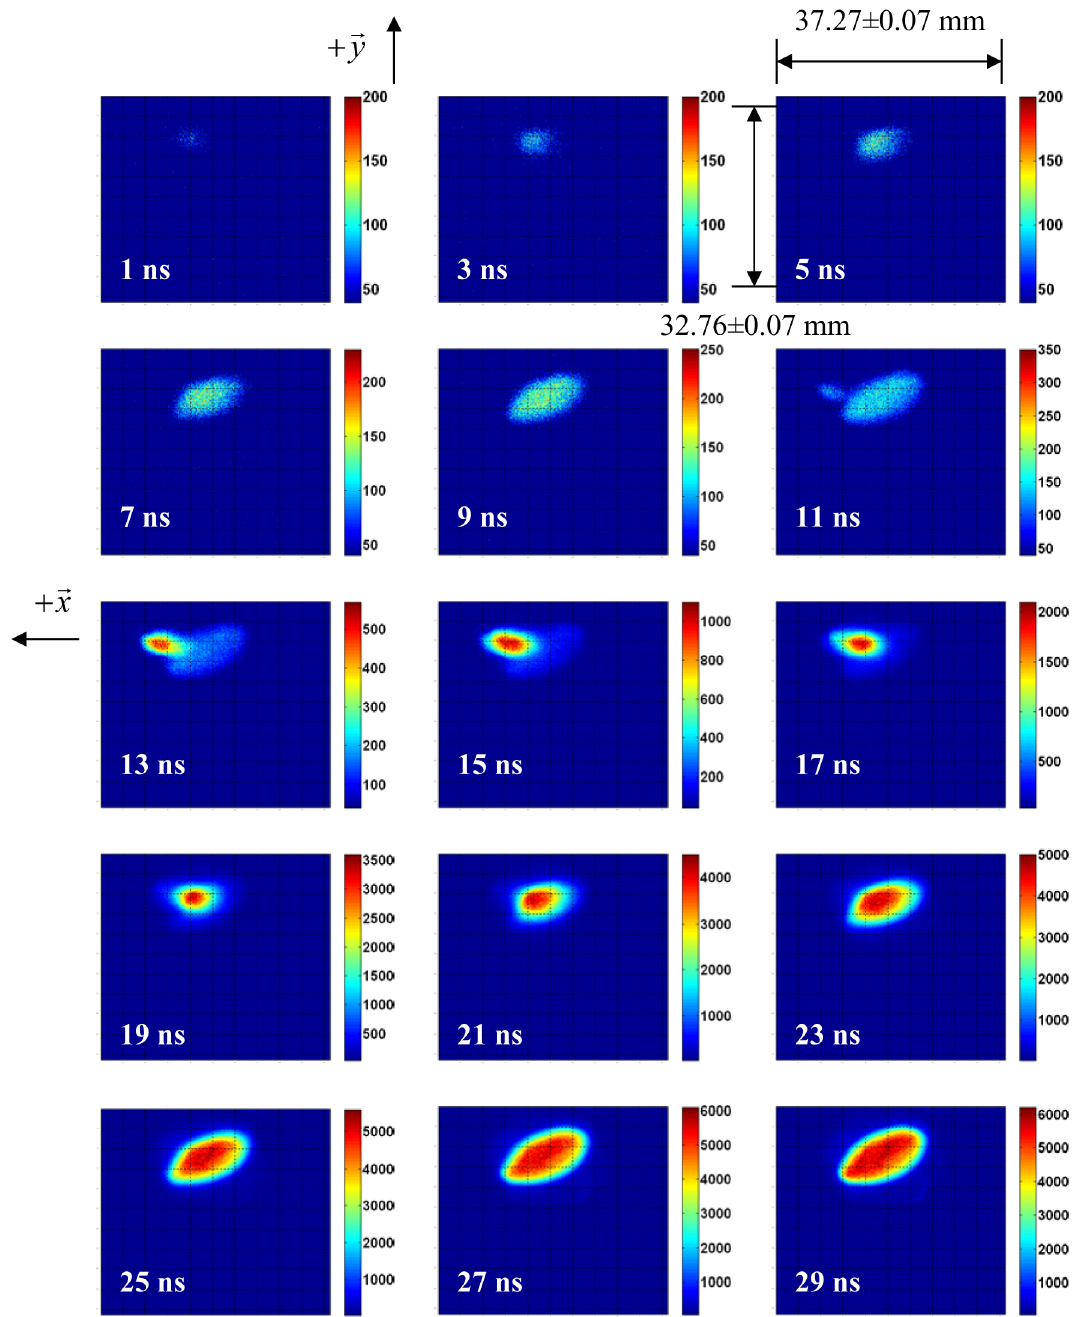
FIG. 9. 3 ns gated camera images of the 21 mA beam head , measured at RC15 as a function of time along the beam